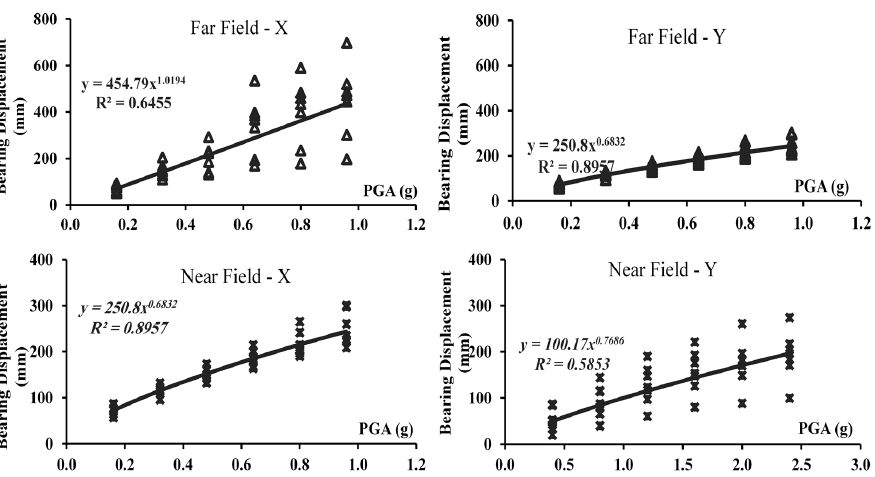
Figure 18. IDA results of bridge bents bearing displacement (BD) demands using far-field ( top ) and near-source ( bottom ) input ground motions in the longitudinal ( left ) and transverse ( right ) directions of the benchmark bridge along with the power law equations.